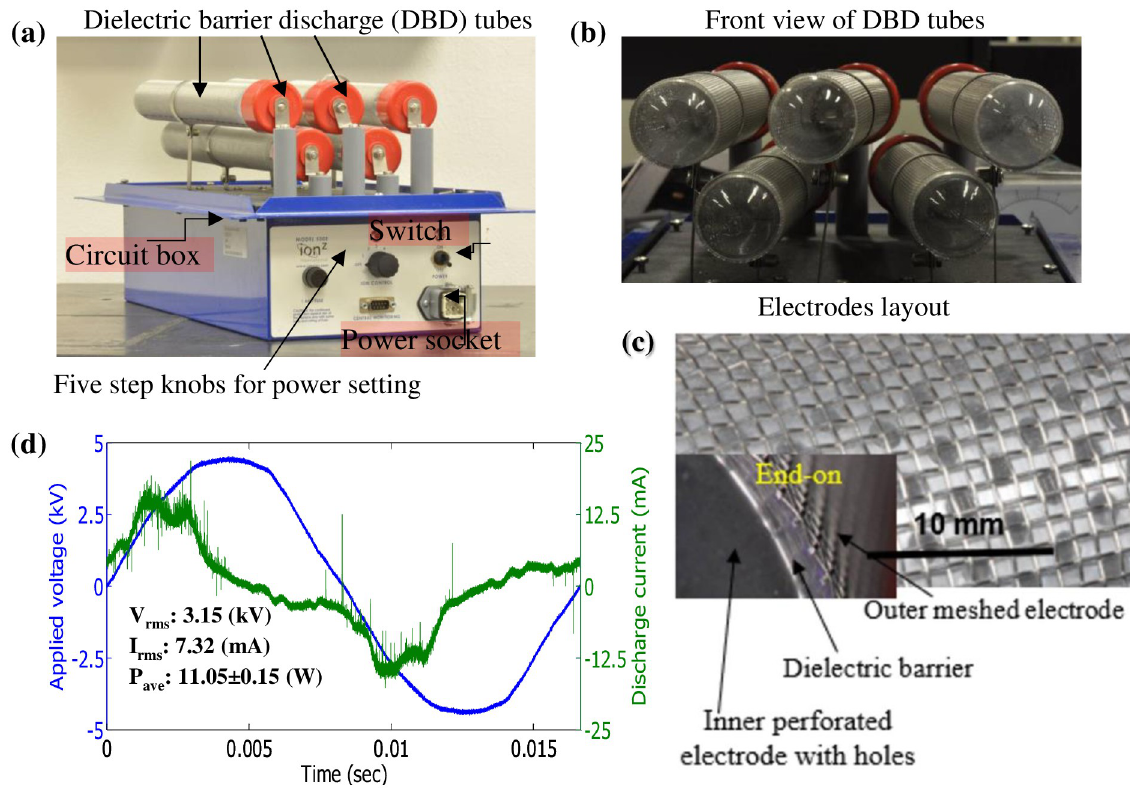
Fig 2. Device configuration of Aerisa 5350/5550: (a) DBD setup, (b) front view of DBD tubes, (c) electrode surface, and (d) voltage- current profile.